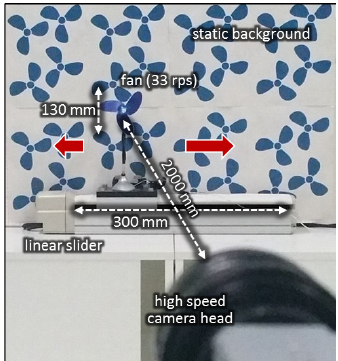
Figure 14. Moving fan against three-blades-patterned background.